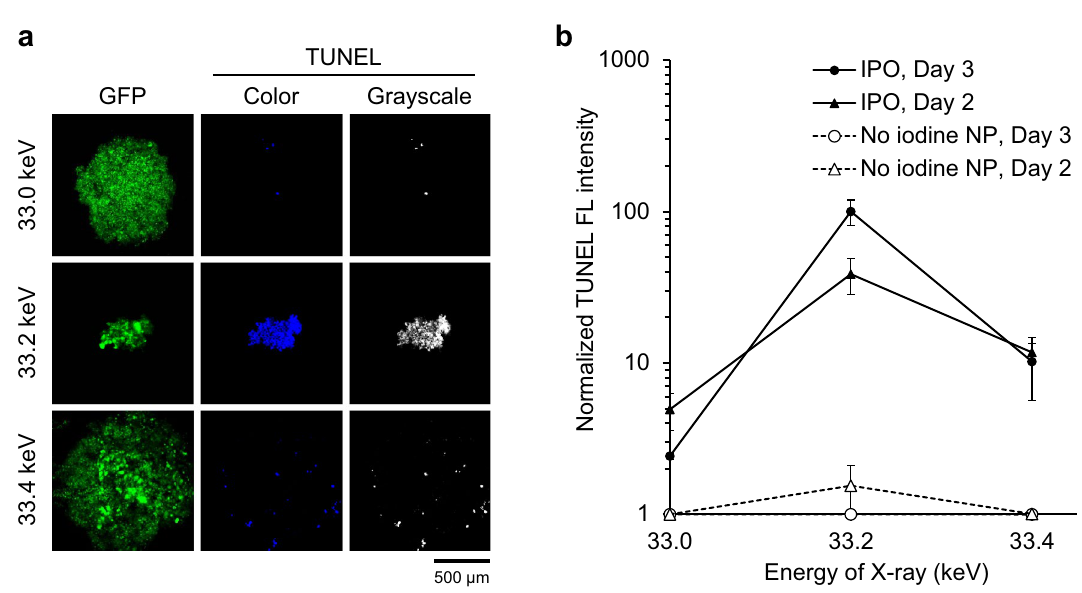
Figure 5. Detection of apoptosis in tumor spheroids by TUNEL assay. OVCAR8 tumor spheroids incubated with IPO were irradiated with 33.0, 33.2 and 33.4 keV monochromatic X-rays for 30 min. After irradiation, spheroids were incubated for 2 or 3 days in a CO 2 incubator and cells were collected and TUNEL staining was performed. ( a ) TUNEL image of OVCAR8 tumor spheroids incubated for 3 days after IPO loading followed by the X-ray irradiation. Images of TUNEL reflecting apoptosis are displayed by blue (color) and white (grayscale). ( b ) Quantification of TUNEL signal. Data after 2-day or 3-day incubation are presented as mean ± s.e.m. ( n = 3). FL